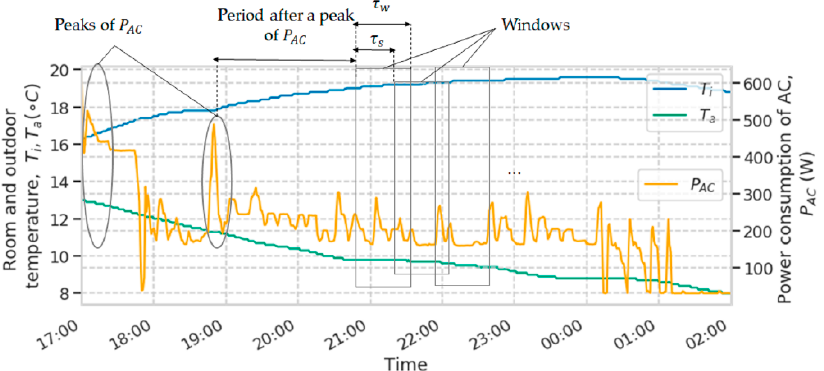
Figure 3. Methods for data selection and preprocessing: The y-axis in the left and right represent temperature in the living room ( T i ) and outdoor ( T a ) and power consumption of the AC ( P AC ), respectively, the x-axis represents time. Data windows with the size of τ w are generated periodically ( τ s after the previous window) 2 h after the peak of P AC .